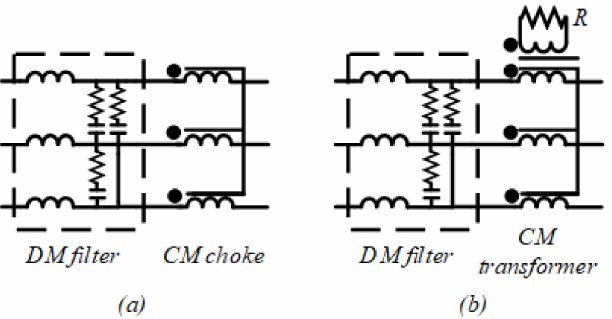
Figure 14. Proposed filter network with CM choke ( a ) and filter network with CM transformer ( b